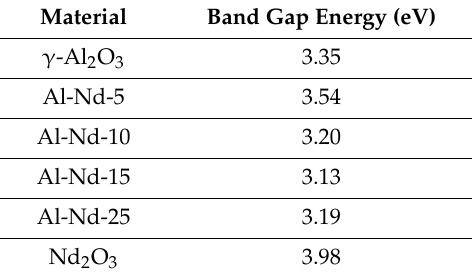
Table 1. Band gap energy of Al 2 O 3 -Nd 2 O 3 binary oxides prepared by the sol-gel method.